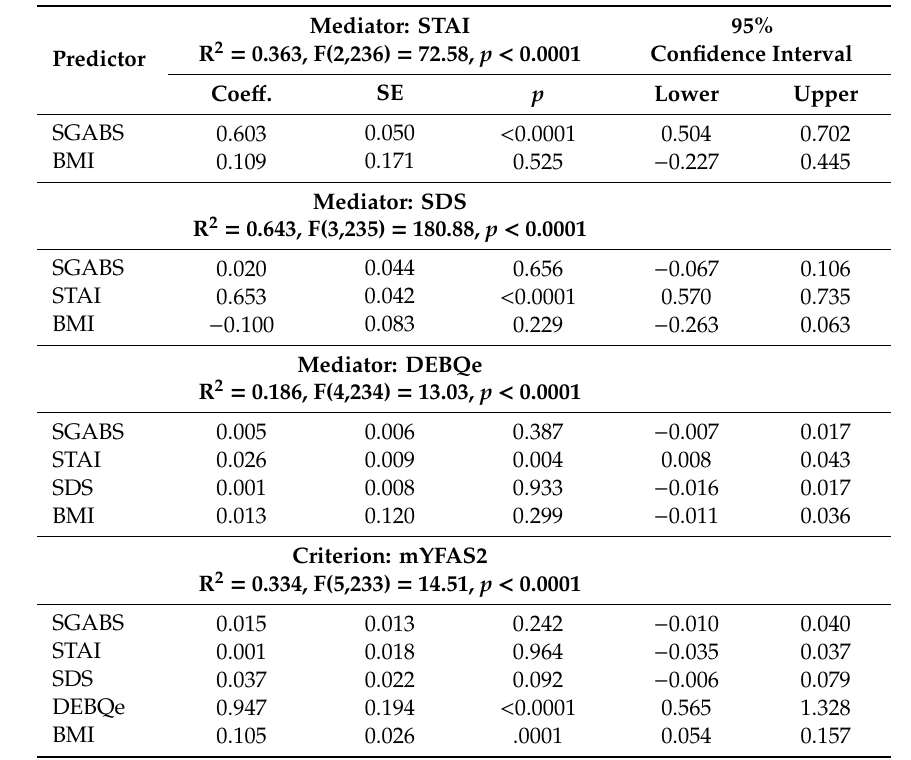
Table 4. Serial mediation analysis predicting mYFAS2 from SGABS. Total e ff ect: R 2 = 0.155, F(2,236) = 16.93, p < 0.0001.